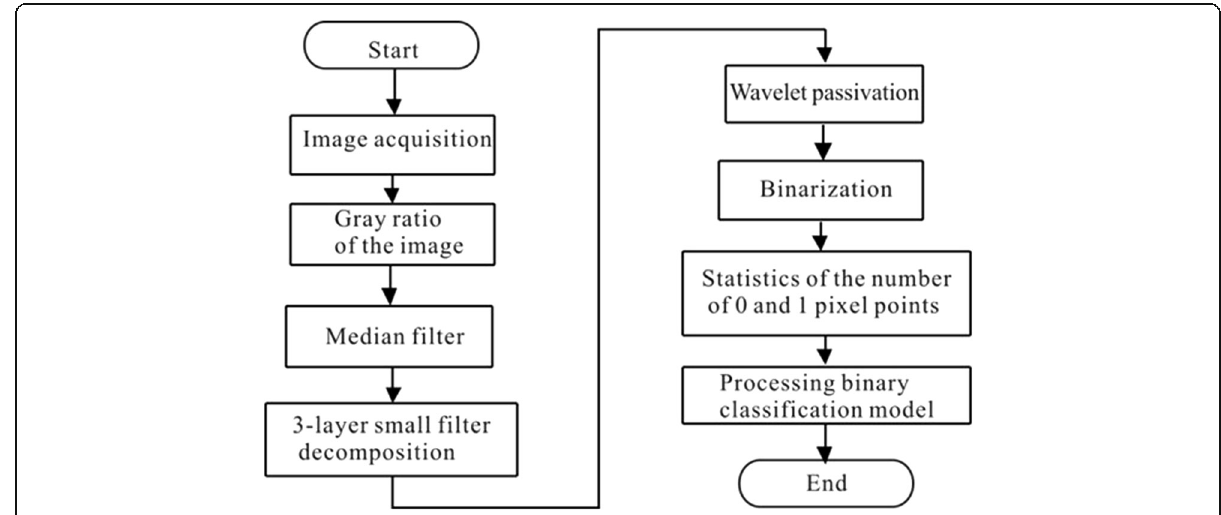
Fig. 3 Flow of the visualized image processing